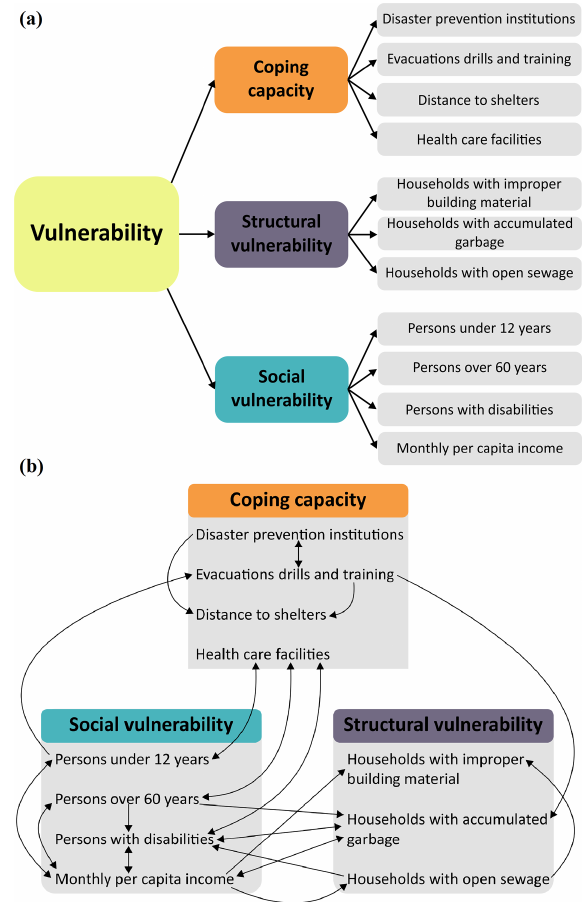
Figure 3. Conceptual models of the flood vulnerability index: (a) AHP hierarchical tree; (b) ANP network, where the arrow direc- tion indicates the interdependence relationships between